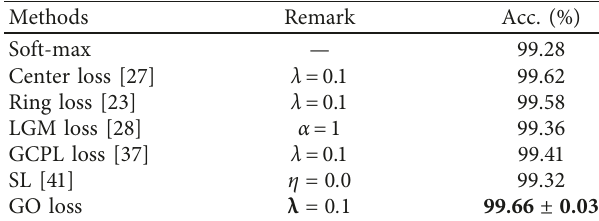
Table 1: Classification accuracy on MNIST dataset.